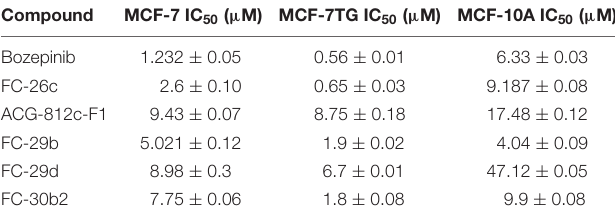
TABLE 1 | Antiproliferative activities a for cyclic and acyclic O,N -acetals compounds against the MCF-7 and MCF7TG cancer cell lines, and the epithelial MCF-10A cell